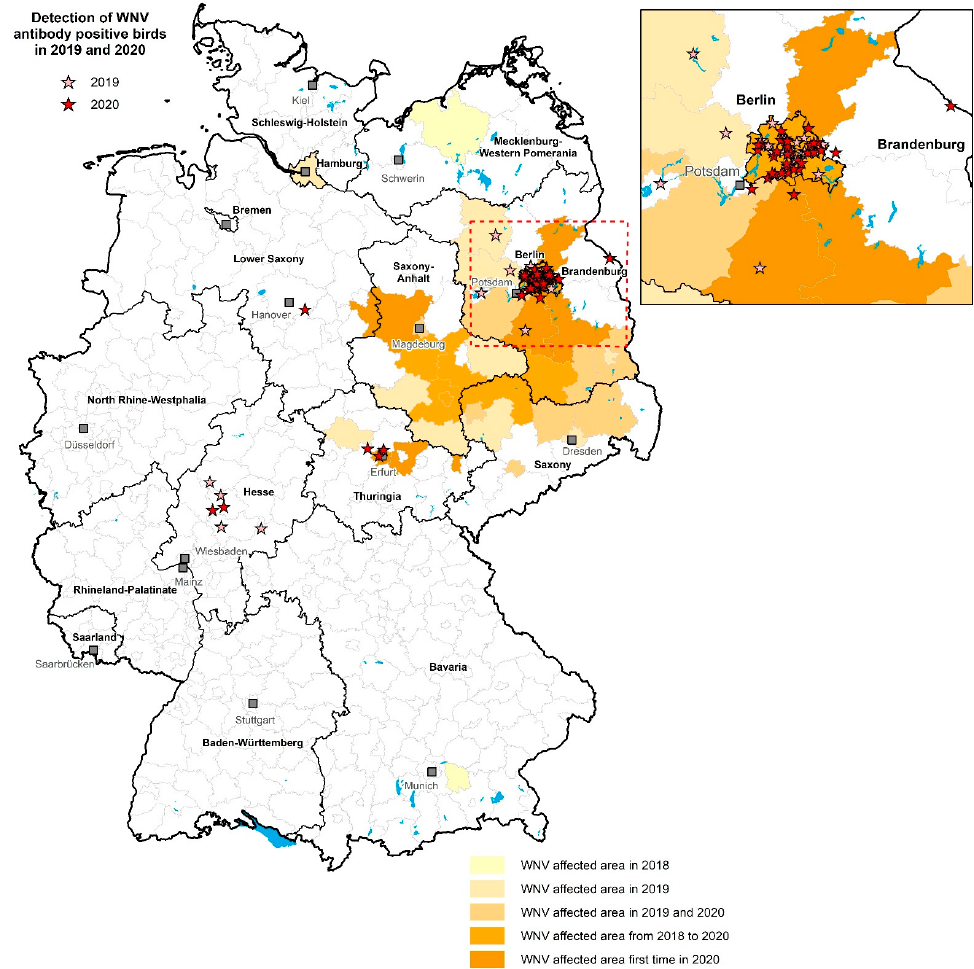
Figure 5. Detection of WNV-antibody-positive wild birds (resident and partial migrants) and their distribution in 2019 and 2020 in Germany. Light red stars represent the situation in 2019, dark red stars are the sites in 2020. The geographical distribution of the WNV-affected areas in Germany since the introduction of the virus in 2018 is shown in different shades of orange based on the extent of infection in each district, as defined by WNV-RNA-positive birds and WNV-RNA- and/or IgM- antibody-positive horses for the past three years (2018 – 2020). The figure includes nine serological results of ten free-ranging goshawks, clinically affected with WNV, which have already been published [56].